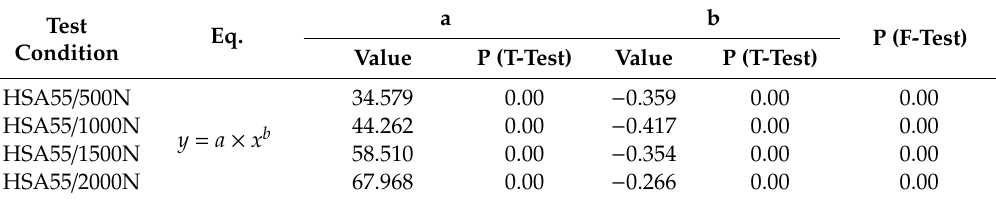
Figure 8. ( a ) Relationship between the contact area and the value of S q under different loads; ( b ) Normal probability graphs of the residual of the corresponding fitting curves. Table 2. Parameters of the fitting curves for different loads